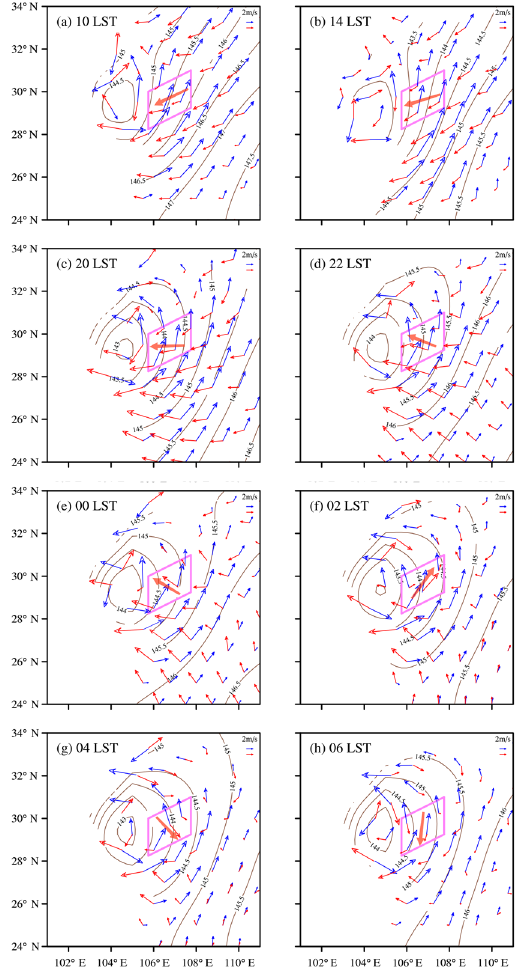
Figure 8. Diurnal variations of geostrophic winds (blue arrows) and ageostrophic winds (red arrows) at ( a ) 10 LST, ( b ) 14 LST, ( c ) 20 LST, ( d ) 22 LST, ( e ) 00 LST, ( f ) 02 LST, ( g ) 04 LST, and ( h ) 06 LST. The large red arrows indicate the prominent direction of ageostrophic winds in region S. The brown solid lines represent the filtered geopotential height.